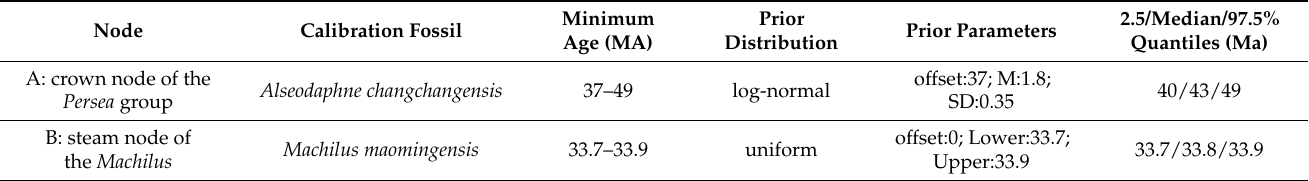
Table 2. Fossil reference points used in this study.